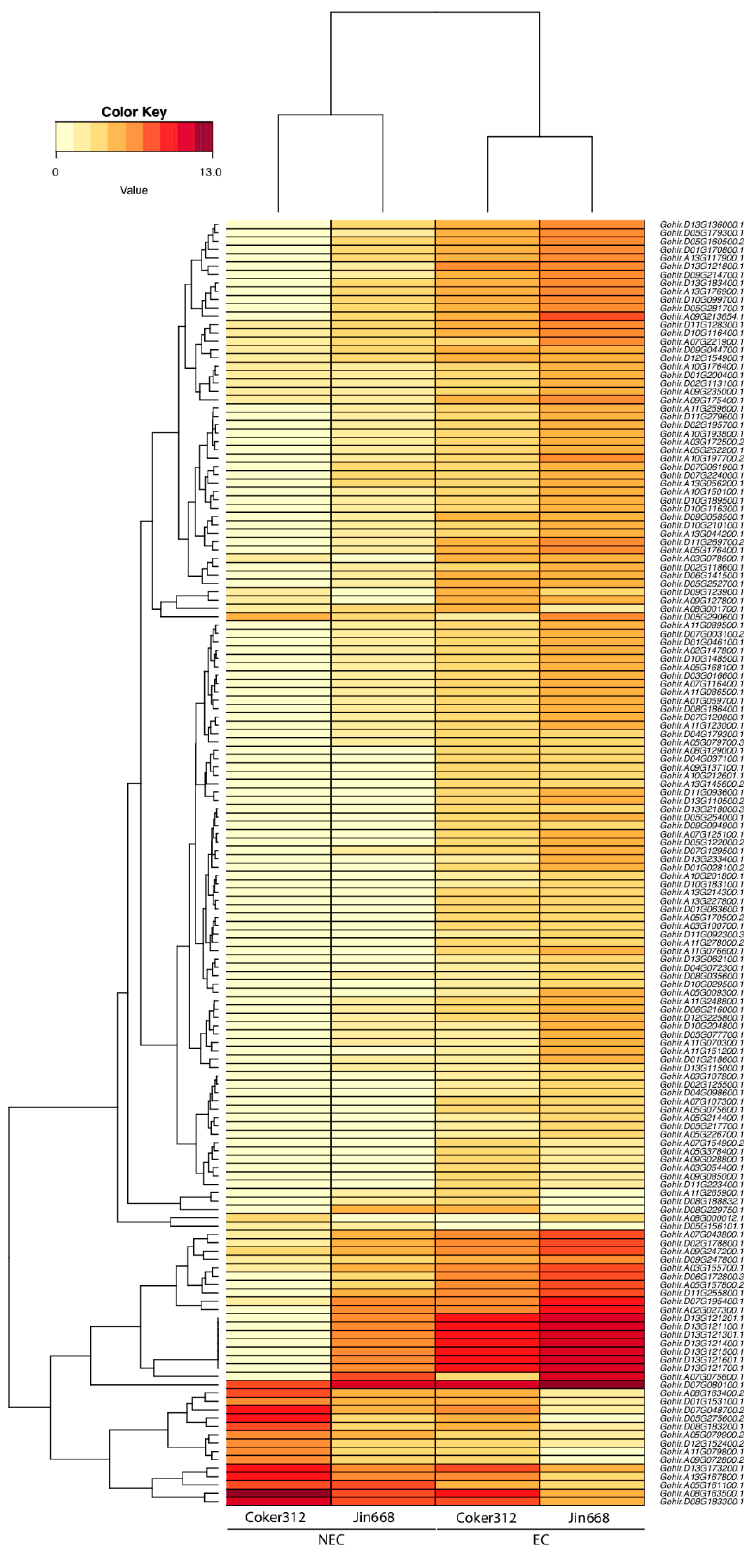
Figure 3. Heatmap representing the gene expression of 154 differentially expressed genes in Coker312 and Jin668 in the NEC and EC callus